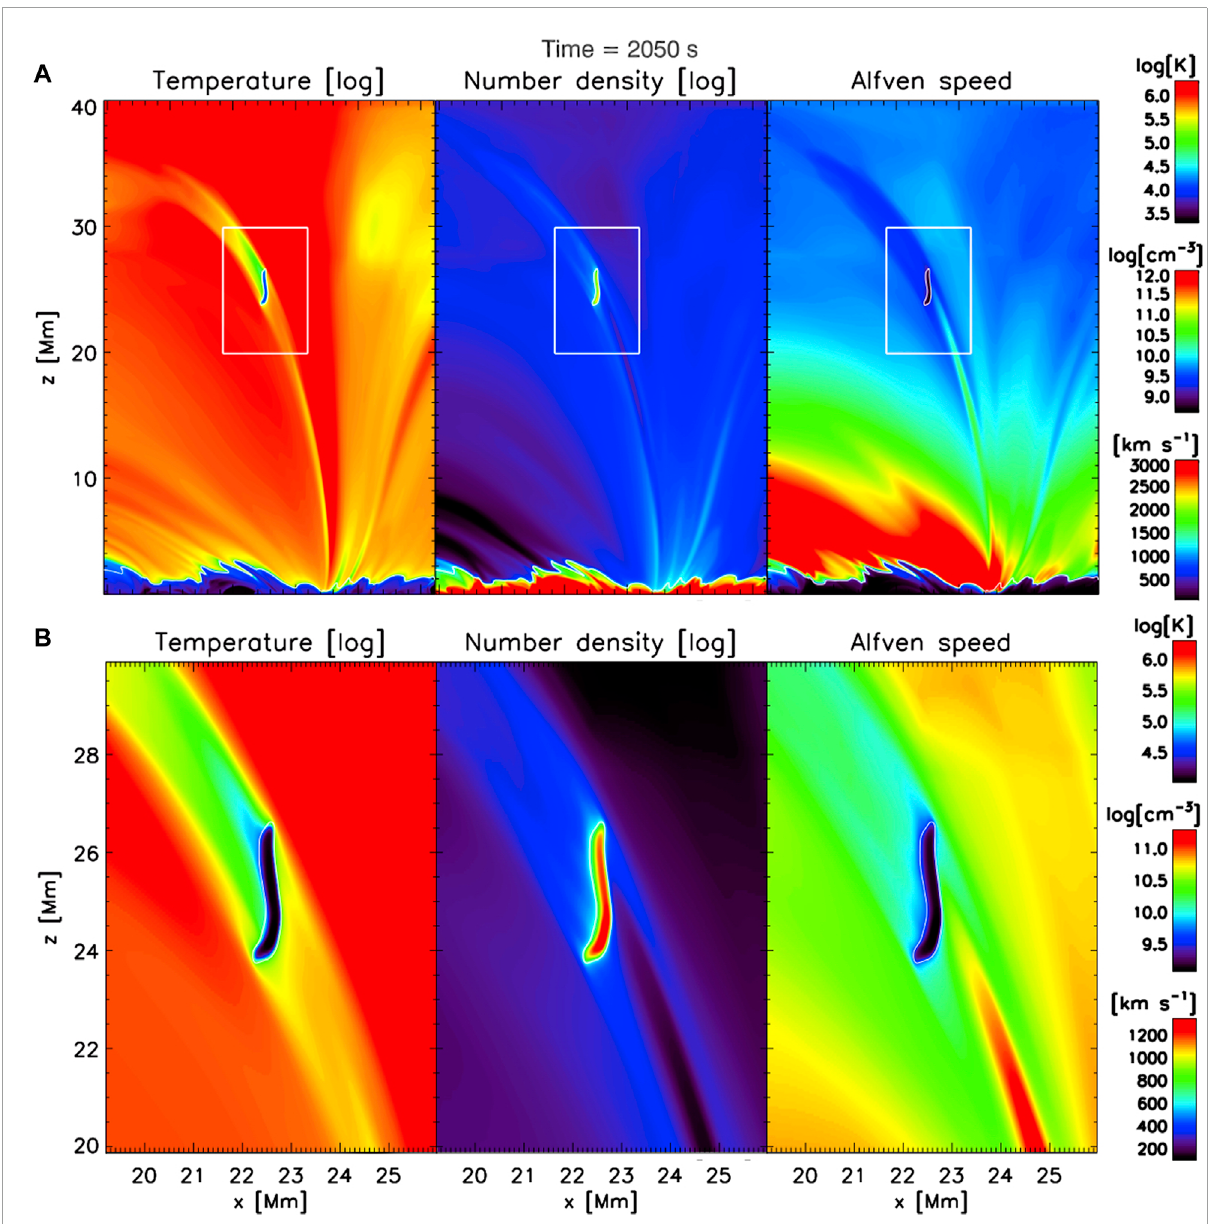
FIGURE 7 Coronal rain event self-consistently produced in a 2.5D rMHD simulation with Bifrost ( Section 2.1 ). (A) (Left to right): snapshot of the temperature (log), mass density (log), and Alfvén speed in a portion of the modeled atmosphere. Thermal instability occurs locally in a coronal loop that is in a state of thermal non-equilibrium, thereby leading to the formation of a condensation (coronal rain clump) falling toward the loop footpoint. (B) (same quantities in same order) shows the white rectangular inset seen in the upper panels (the three color bars on the right of each row correspond uniquely to that particular row). Taken and adapted from Figures 2 , 3 of Antolin et al.